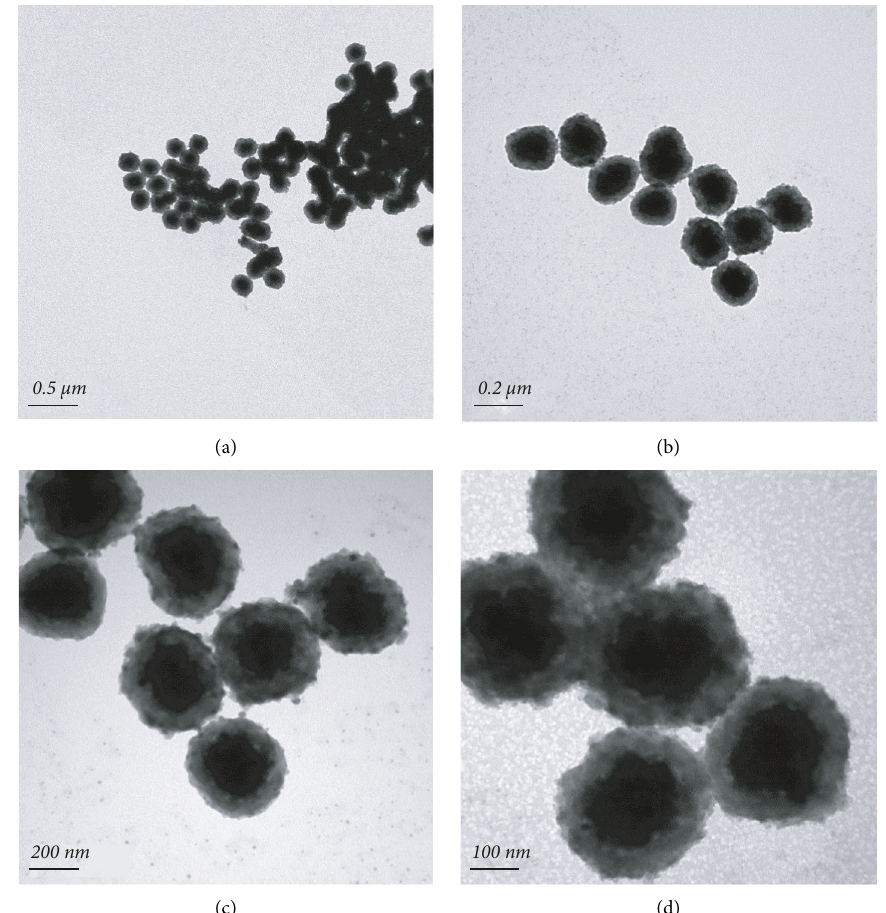
Figure 2: (a–d) The TEM images of the as-prepared Fe